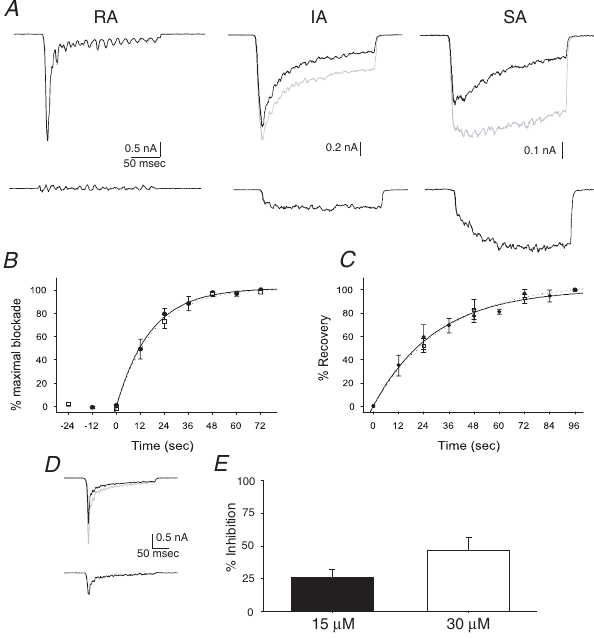
Figure 2. NMB-1 has 30-fold selectivity for ion channels underlying SA currents over those mediating RA currents. ( A ) Upper . Example traces showing the action of 1 m M NMB-1 on RA ( left ), IA ( center ) and SA ( right ) currents; control responses are in gray and currents in NMB-1 are in black . NMB-1 had no effect on RA currents but had significant inhibitory effects on IA and SA currents. Lower , Subtraction of traces recorded in 1 m M NMB-1 from control traces shows that NMB-1 selectively inhibits a persistent component of the response at this concentration. ( B ) The rate at which blockade by NMB-1 develops is independent of stimulation frequency (i.e. channel open time). 1 m M NMB-1 was applied to 3 neurons that were stimulated at 12 and 24 sec intervals; the association constants were 2.50 6 10 4 M 2 1 s 2 1 and 2.47 6 10 4 M 2 1 s 2 1 , respectively. ( C ) The rate at which blockade by NMB-1 is relieved following drug removal is also independent of stimulation frequency. For 1 m M NMB-1 (n=3) the disassociation constants were 0.034 s 2 1 (12 sec) and 0.029 s 2 1 (24 sec). ( D ) Example traces showing the effect of 30 m M on a RA current ( top ) and the blocked current (from subtraction, bottom ). ( E ) Summary of inhibition of RA currents by 15 m M and 30 m M NMB-1 (n=4); currents were inhibited by 25.9 6 6.3% and 46.8 6 9.5%,